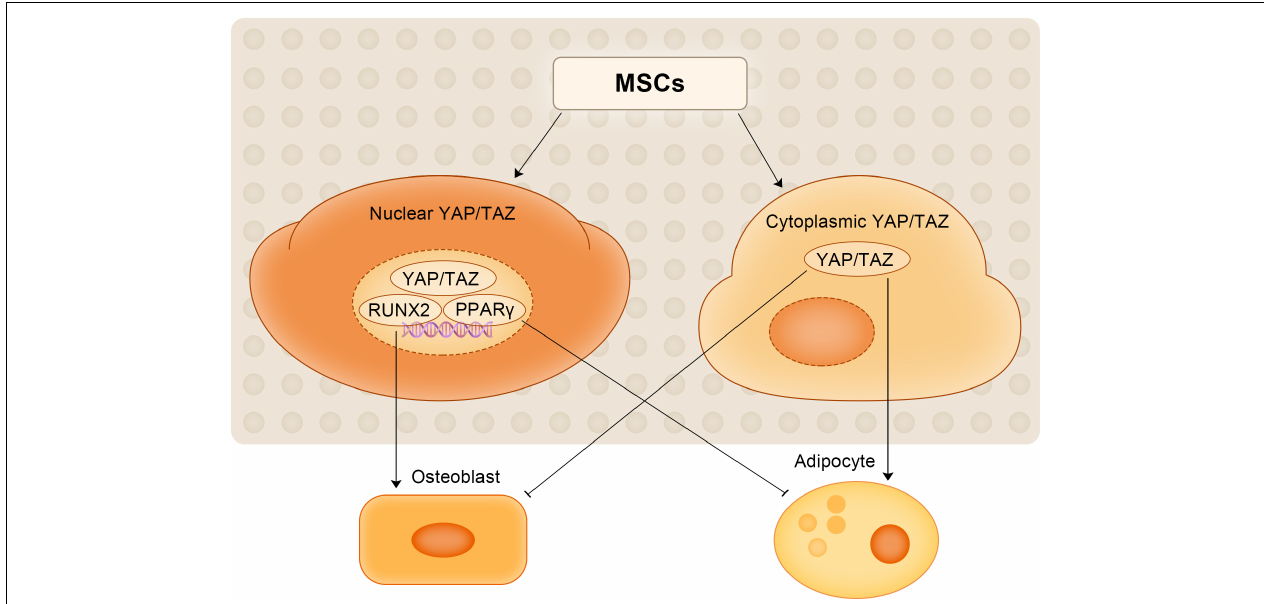
FIGURE 3 | The regulatory role of YAP1/TAZ in the osteogenic and adipogenic differentiation of